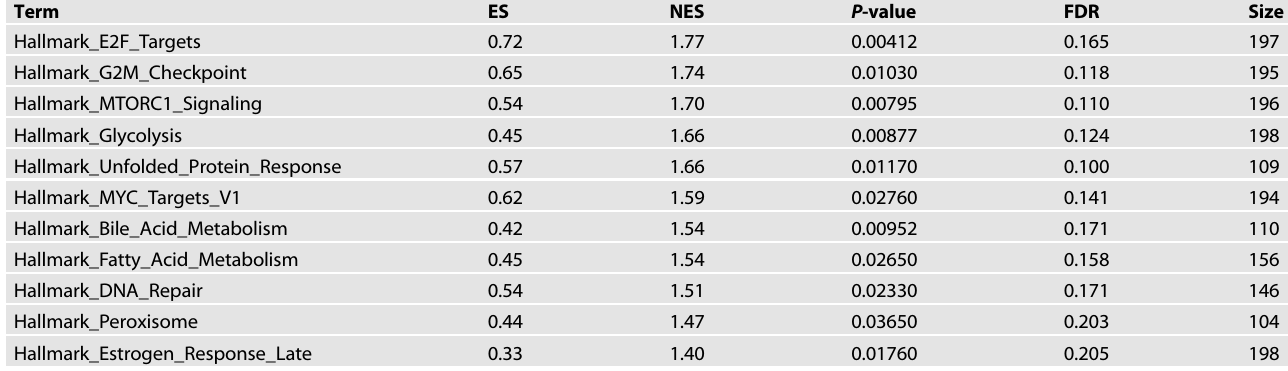
ES Enrichment Score, NES Normalized Enrichment Score, FDR False Discovery Rate.